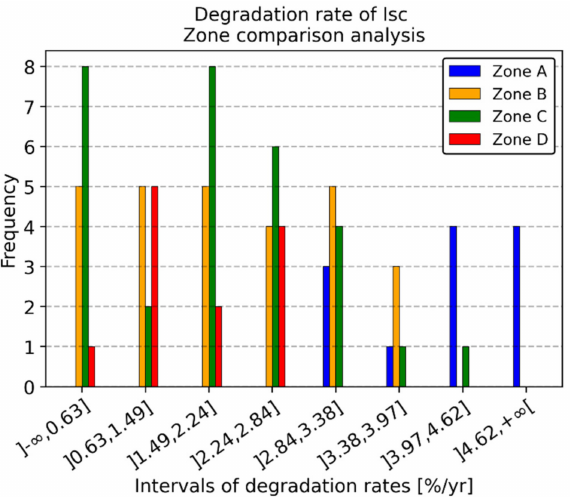
Figure 10. Zone analysis of the degradation rate of the short-circuit